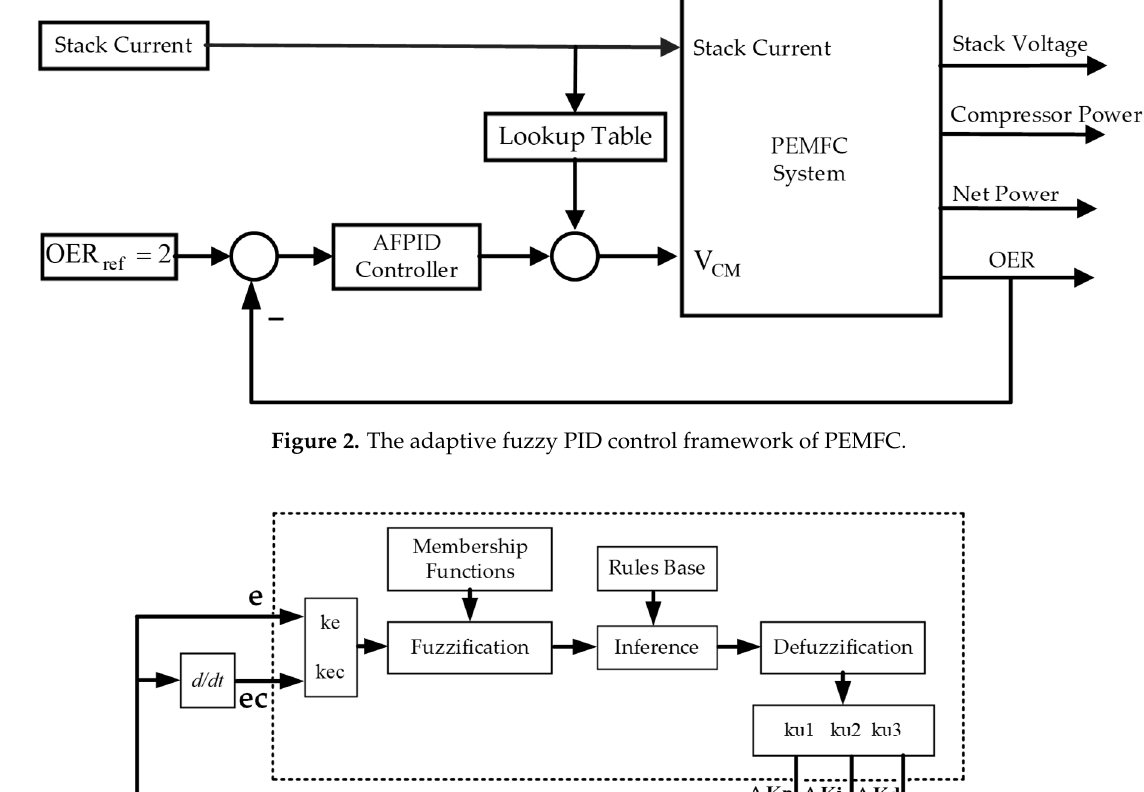
Figure 2. The adaptive fuzzy PID control framework of PEMFC.